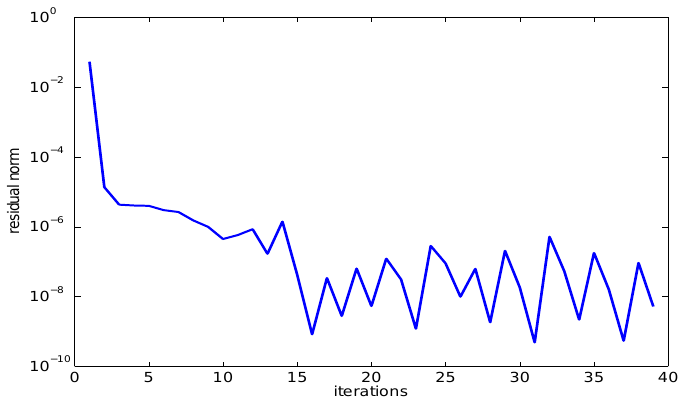
Figure 2. Convergence history: nonlinear Arnoldi with block Cholesky